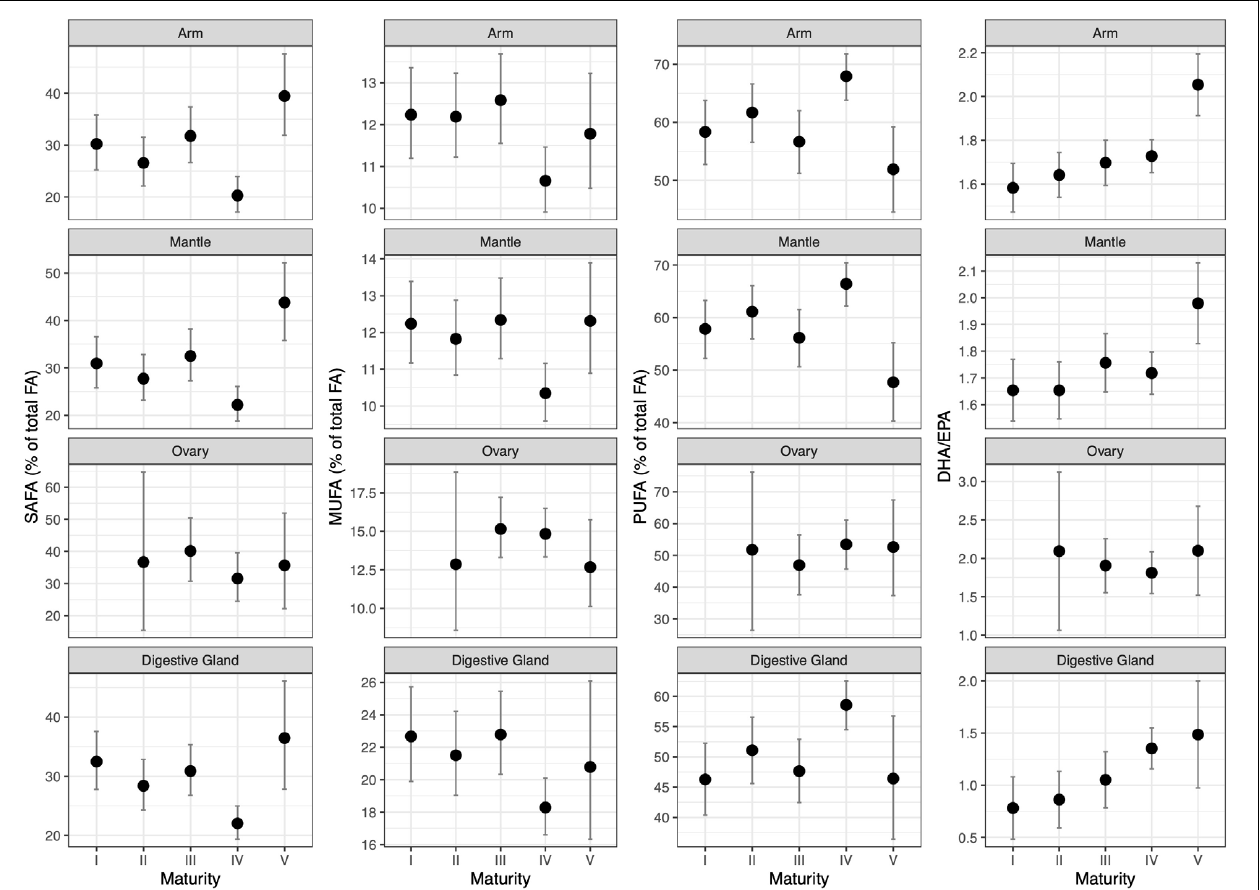
FIGURE 7 | Differences in the proportion of fatty acids groups (SAFA, MUFA, and PUFA) and DHA/EPA ratio (across columns) per tissue (along rows) across maturity stages once accounting for seasonality ( Supplementary Figure 9 ) and tissue weight (body for arm and mantle tissues, ovary or digestive gland log-transformed weight) ( Supplementary Figure 10 ) as obtained from fitting beta regression models. Predicted values were obtained for an individual of 1.5 kg in